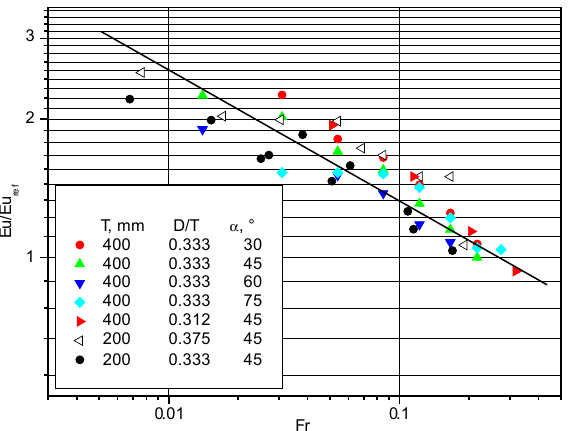
Figure 9. Increase in mixing power when emptying the tank for various sizes of impellers.